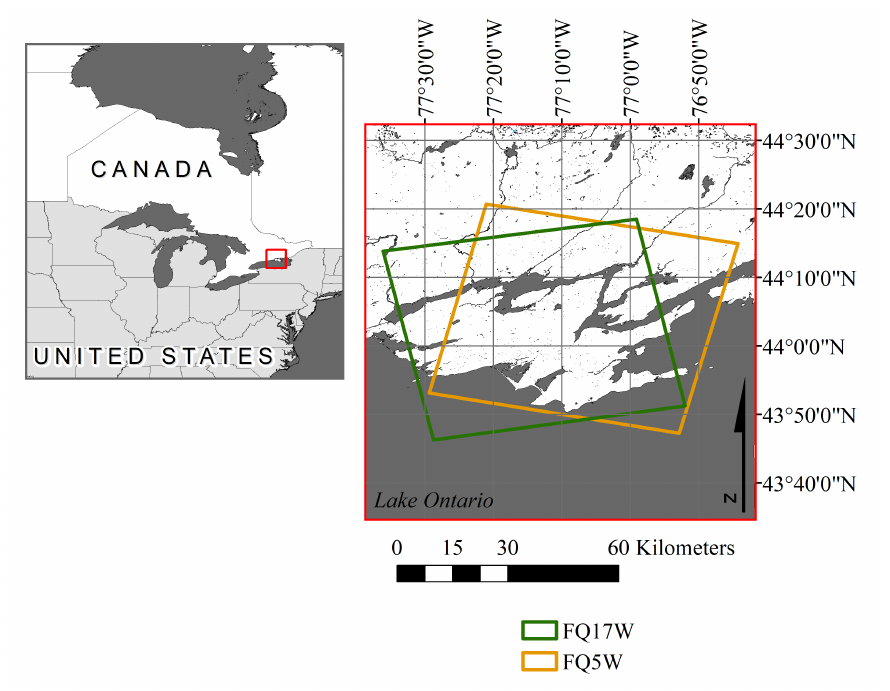
Figure 1. Location of the study area on the northern shore of Lake Ontario, Canada showing the footprint of the FQ5W (orange) and FQ17W (green) RADARSAT-2 images evaluated in this research.